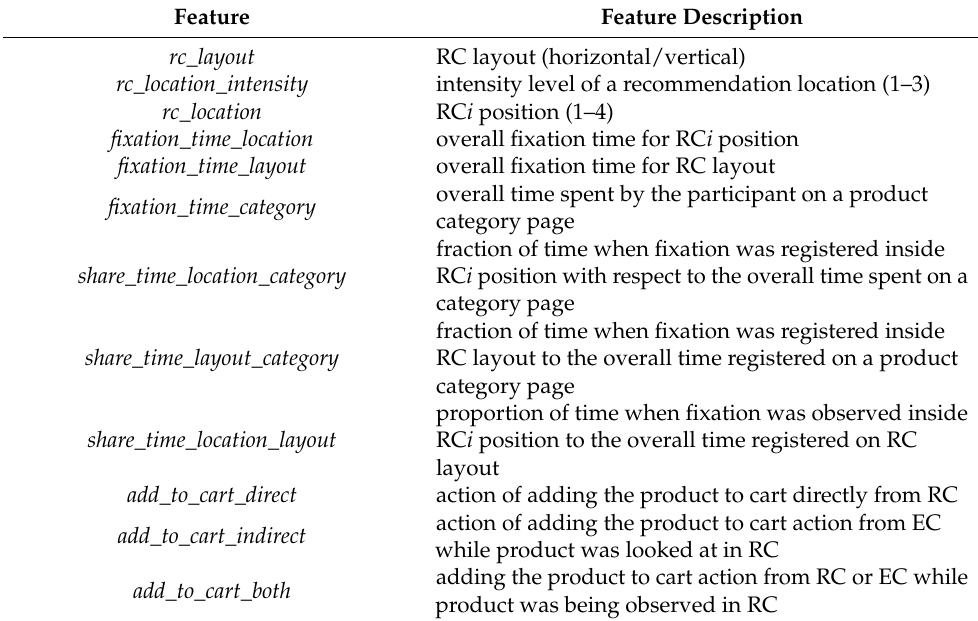
Table 2. Features generated based on eye-tracking device.